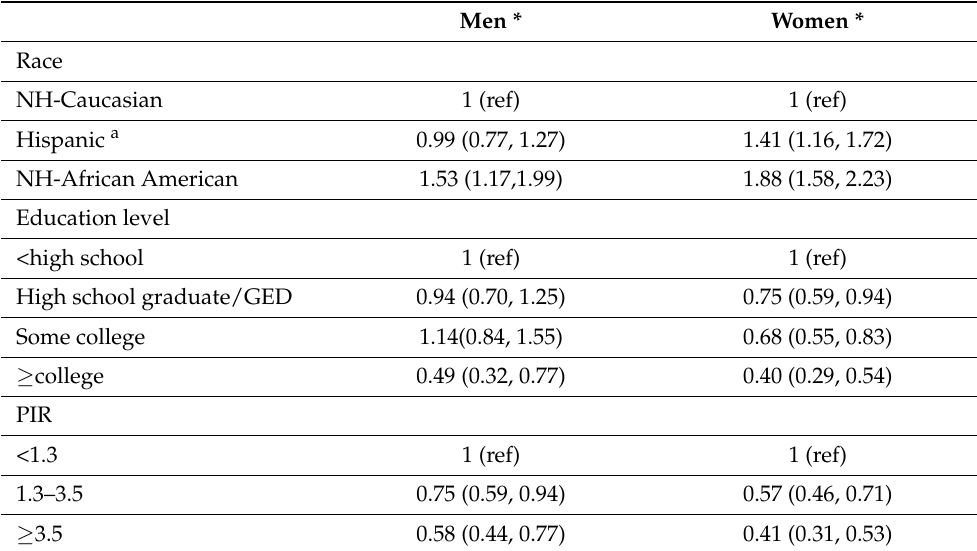
Table 2. Association between rheumatoid arthritis and race, education level, and poverty income ratio in both men and women: 2005–2006 through